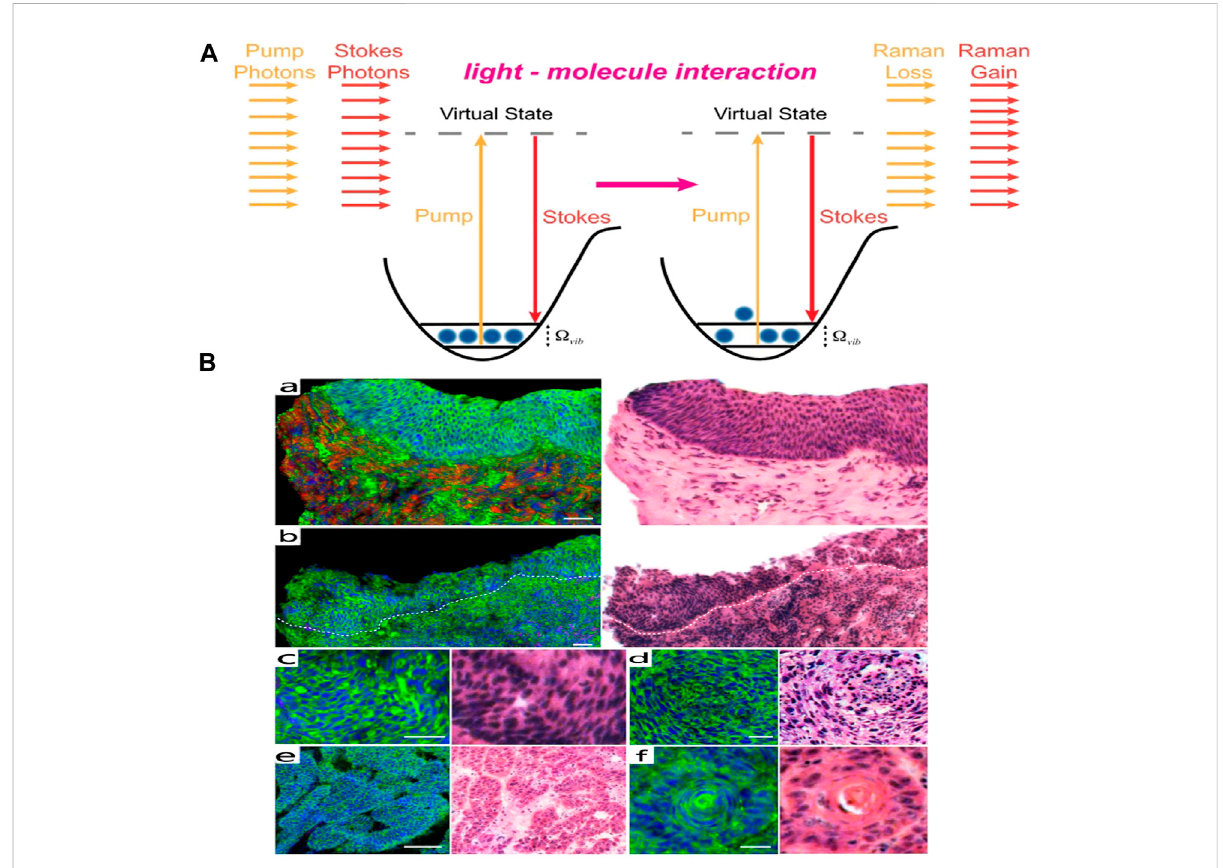
FIGURE 1 (A) Schematic of the stimulated Raman scattering (SRS) [30] and (B) SRS and hematoxylin and eosin (H&E) images of frozen sections obtained from laryngeal squamous cell carcinoma tissues. a: Laryngeal squamous cell carcinoma in situ ; b: Invasive squamous cell carcinoma; c: Cytological atypia; d: Cytologicalatypia accompanied with lymphocytes and architectural neoplasm; e: Cancer nests; and f: A typical keratin pearl. Scale bars: 100 µm (b and e), 30 µm (a, c, d, and f)